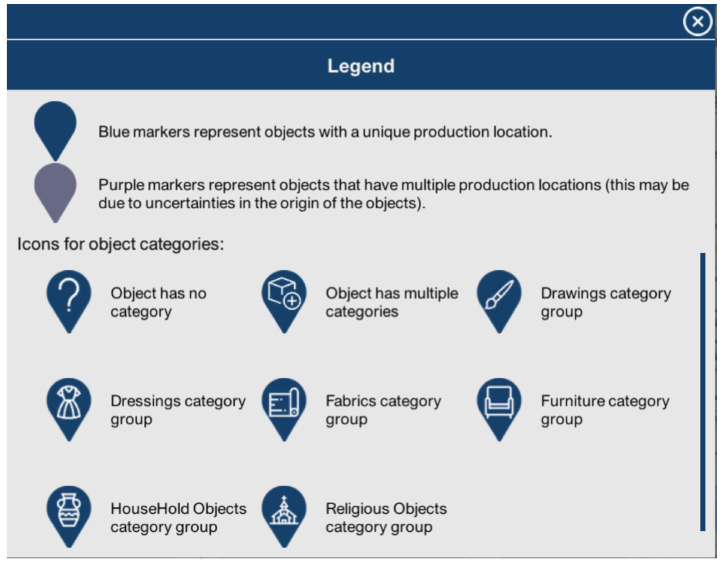
Figure 8. Icons (and their meanings) shown in STMaps for the objects in